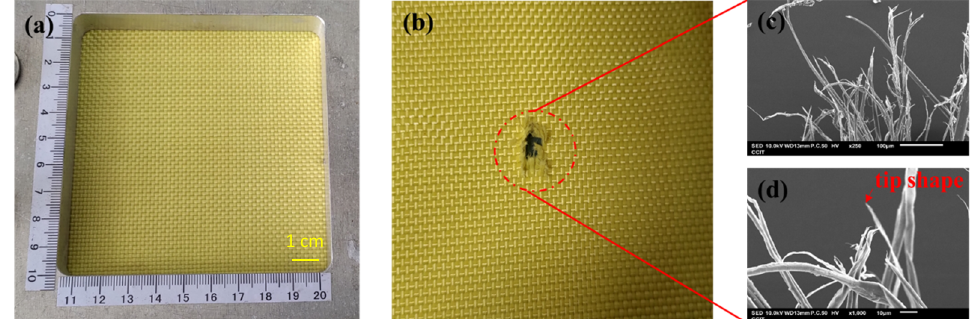
Figure 7. Observation of the single-ply ( a ) Epoxy/Kevlar plate before the ballistic test; ( b ) failed fabric with Epoxy/Kevlar plate after ballistic test; ( c ) the close-up look of the failed fibers in ( b ); ( d ) the zoomed-in image of the failed fibers in ( c ).